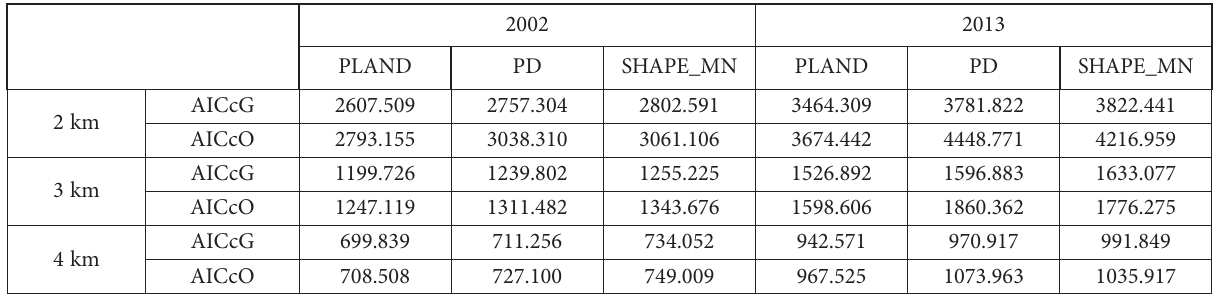
Table 9. Comparison of AICc between GWR and OLS